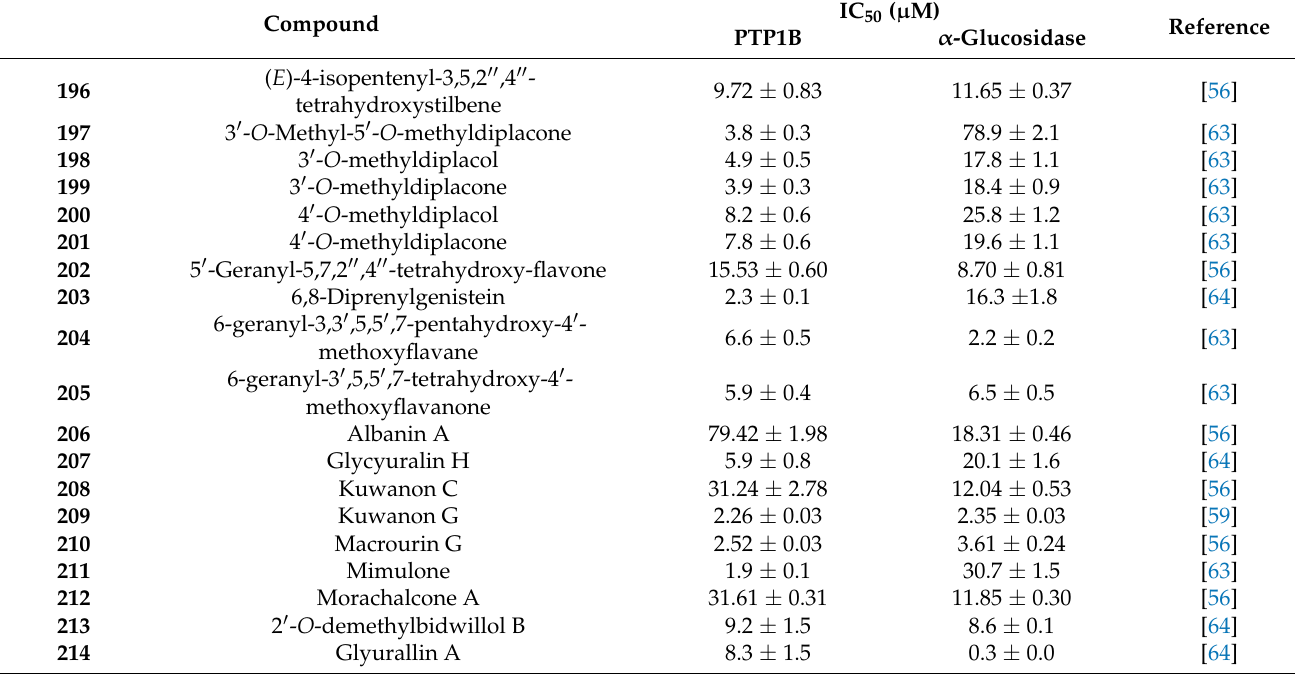
Table 9. Prenylated phenolic